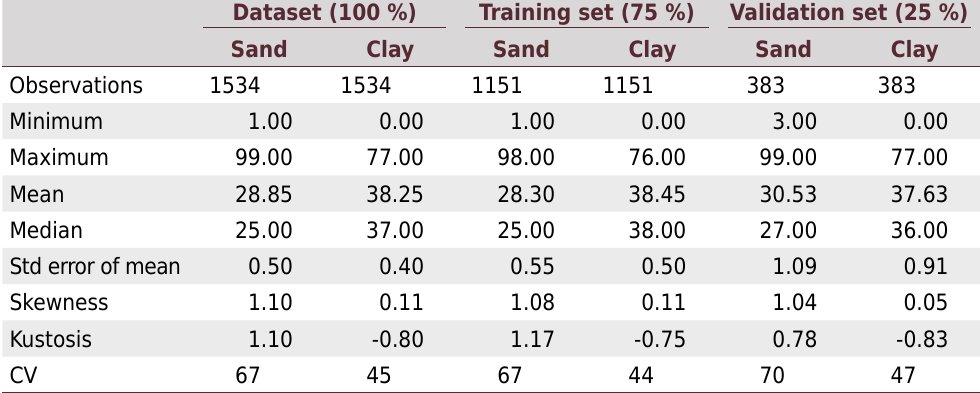
Table 1. Descriptive statistics of soil properties for dataset, training set and validation